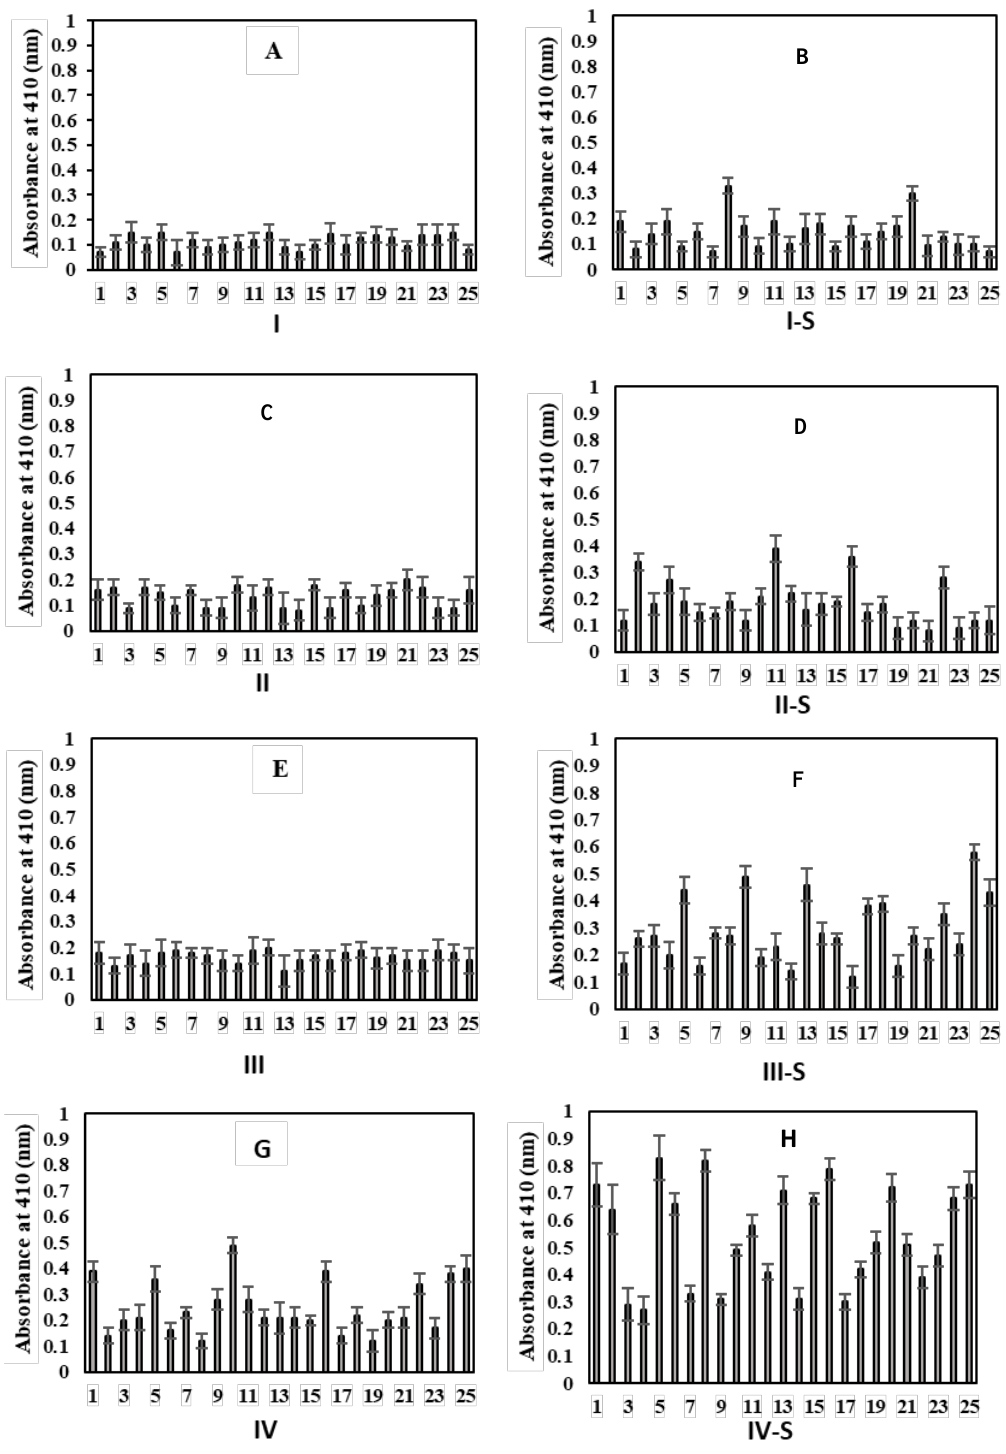
Figure 3. Direct binding ELISA for serum samples (1:100 diluted) for the detection of serum autoantibodies against Gly-HSA from individuals from various groups. Figures A–H represent; groups ( A ): I (21–40), ( B ): I-S (21–40), ( C ): II (41–60), ( D ): II-S (41–60), ( E ): III (61–80), ( F ): III-S (61–80), ( G ): IV ( > 80), and ( H ): IV-S ( > 80), respectively. ‘S’ represent subjects who are smokers. Each sample was run in triplicate and data is presented as mean ±